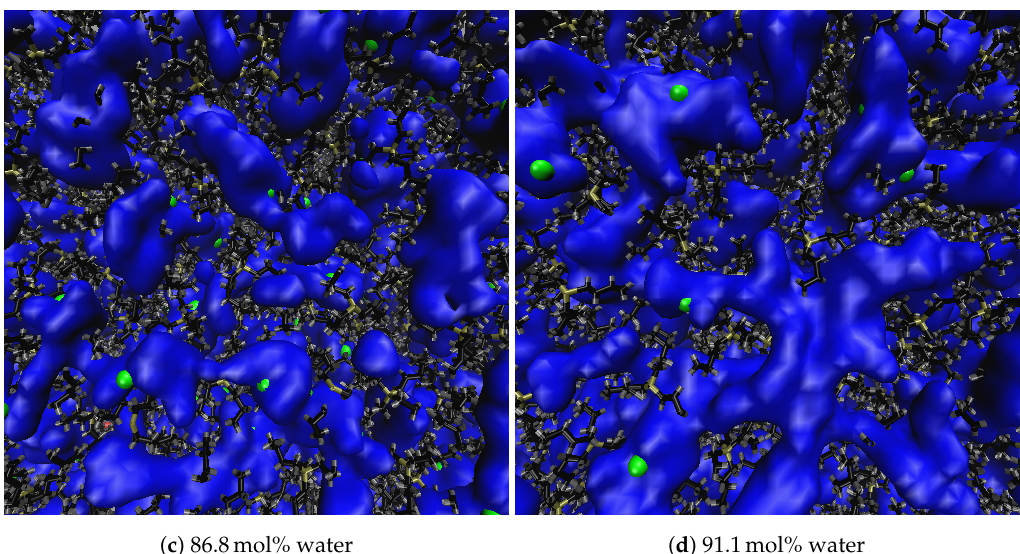
Figure A3. Water veins and channeling in TBPCl at 360K (Part 1 of 2) [27,28]. The Figures represent the changing water structure with increasing water concentration: ( a ) 63.1mol% water; ( b ) 79.4mol% water; ( c ) 86.8mol% water; ( d ) 91.1mol% water. The blue-colored water is represented using an isosurface drawing method (called quicksurf in VMD [13]), which uses a volumetric Gaussian density map of the water to produce the observable surface. The TBP molecule is represented using dynamic bonds in VMD [13]. TBP is colored tan, black and gray, for the phosphorus, carbon, and hydrogen atoms, respectively. The green chloride is represented using the Van Der Walls (VDW) drawing method in VMD [13].